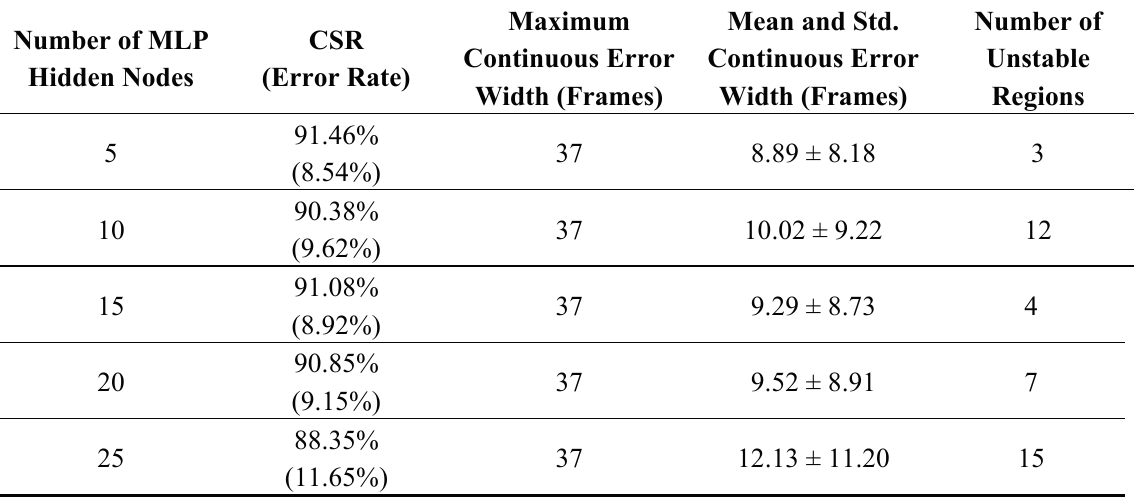
Table 4. Online classification results of walking phase classifiers with MLP